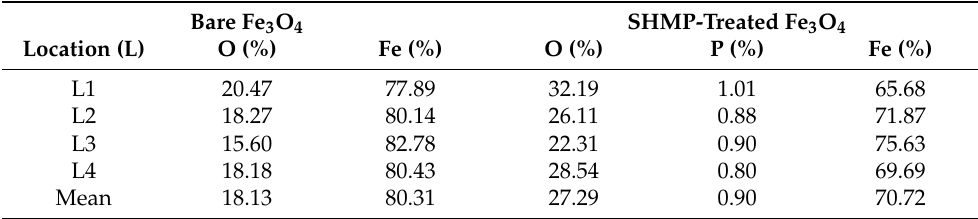
Figure 4. SEM microstructure images of ( a , b ) bare Fe 3 O 4 , and ( c , d ) SHMP-treated Fe 3 O 4 samples at different magnification (25,000X and 100,000X). Table 2. EDX analysis as elemental weight (%) across different locations of bare and treated Fe 3 O 4